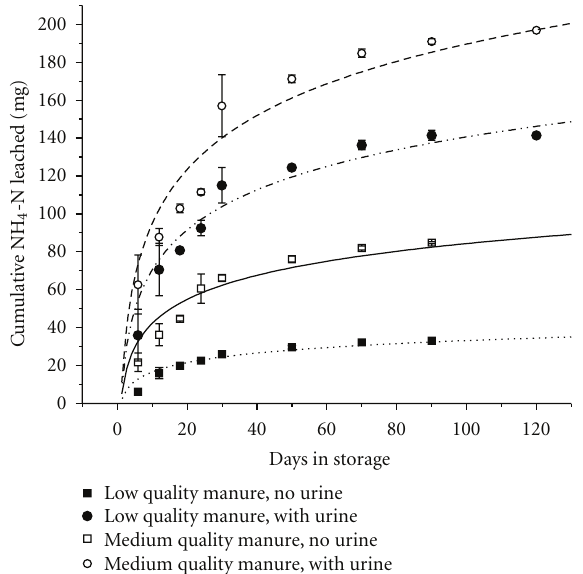
Figure 6: Cumulative NH 4 -N (mg NH 4 -N per manure storage unit) leached from manure of the dry season storage experiment. Error bars represent standard error of the mean values. Continuous lines represent best-fit regression equations for cumulative NH 4 - N (mg) leached from manure during the dry season experiment. The solid line (—) represents the Medium quality manure, no urine treatment. The dashed line (----) represents the urine- amended Medium quality manure treatment. The dotted line ( ···· ) represents the Low quality manure, no urine treatment. The dot-dash line (- ·· - ·· ) represents the urine-amended Low quality manure treatment. Y represents the cumulative NH 4 -N (mg) leached from the manure. Medium quality manure, no urine: Y = 18 . 3144ln( x ), R 2 = 0 . 989. Medium quality manure, with urine: Y = 41 . 1785ln( x ), R 2 = 0 . 993. Low quality manure, no urine: Y = 7 . 1964ln( x ), R 2 = 0 . 988. Low quality manure, with urine: Y = 30 . 5345ln( x ), R 2 = 0 . 994. The rate equations for leachate NH 4 -N between the four treatments did not di ff er at significance level α = 0.05.